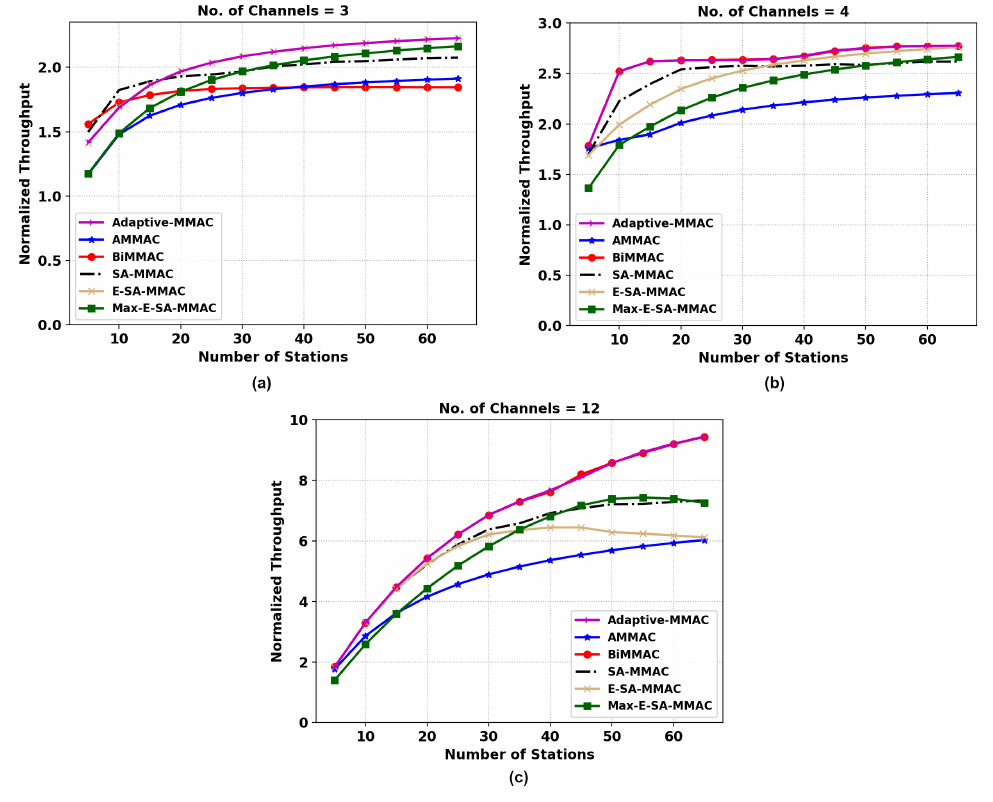
Figure 9. Normalized throughput comparison of adaptive MMAC versus others. ( a ) Three, ( b ) four, and ( c ) twelve